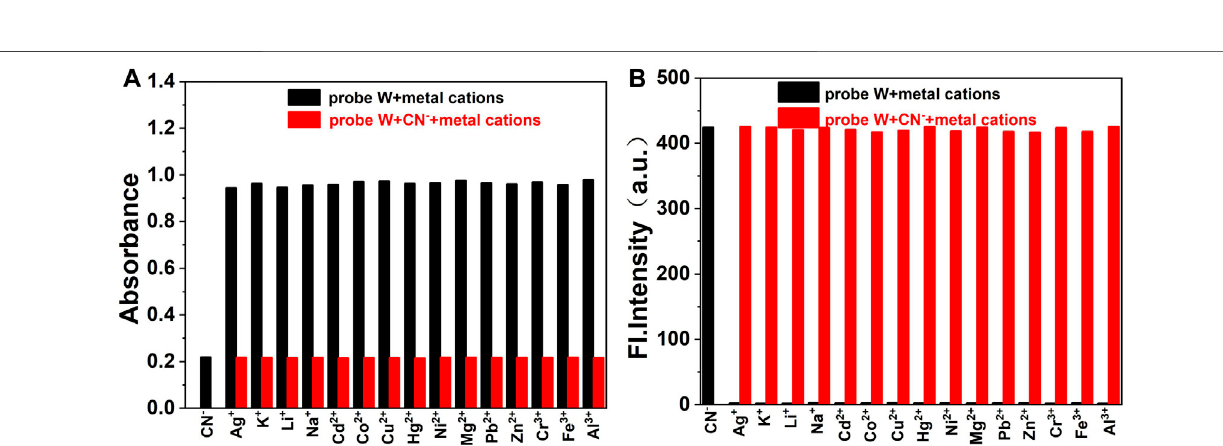
Frontiers in Chemistry |